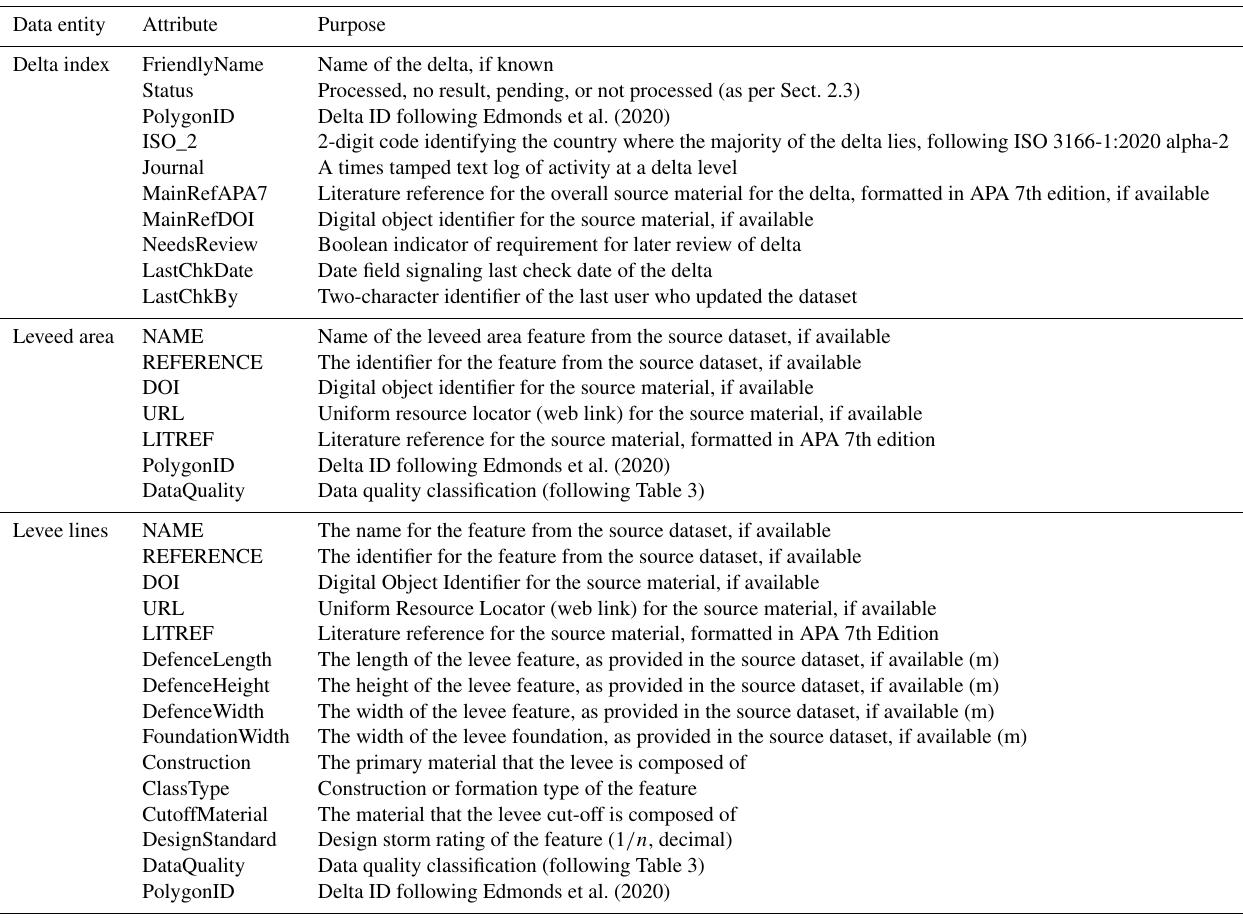
Table 2. openDELvE attributes for the three data elements (as per Table 1). Conversion factors and mapping of fields are given in Table S2 (in the